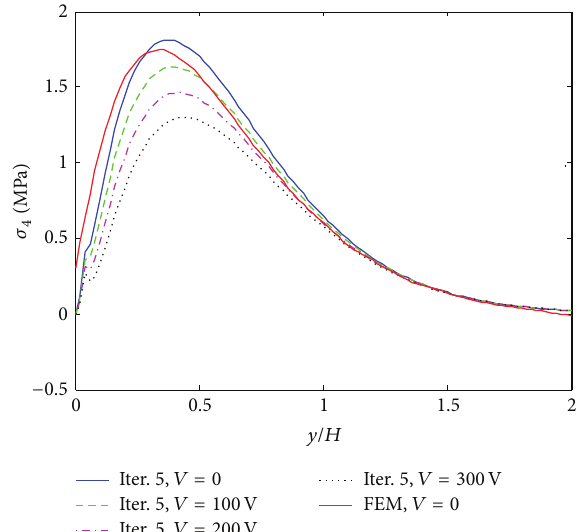
Figure 11: 𝜎 4 distribution of [PZT/45 4 / − 45 4 ]s laminate at the interface of 𝑧/𝐻 = 1/6 , under − 0.1% uniaxial strain.